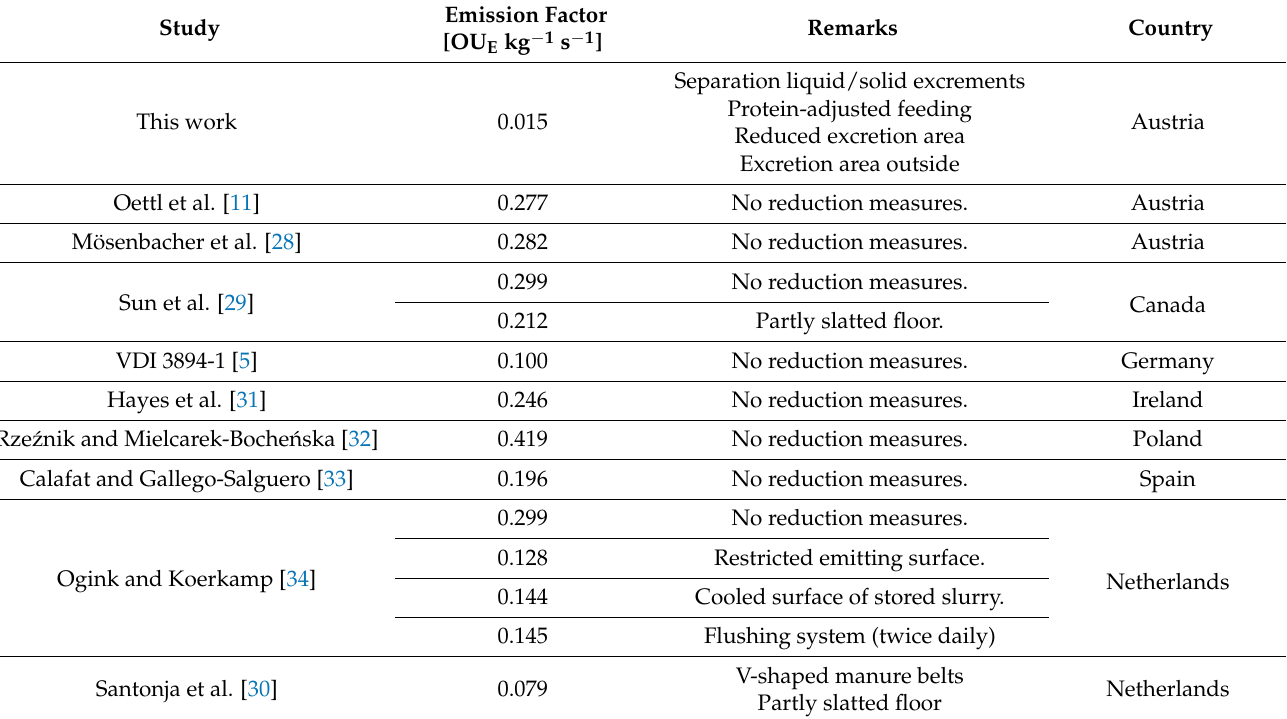
Table 3. Comparison of published emission factors for fattening piggeries in the